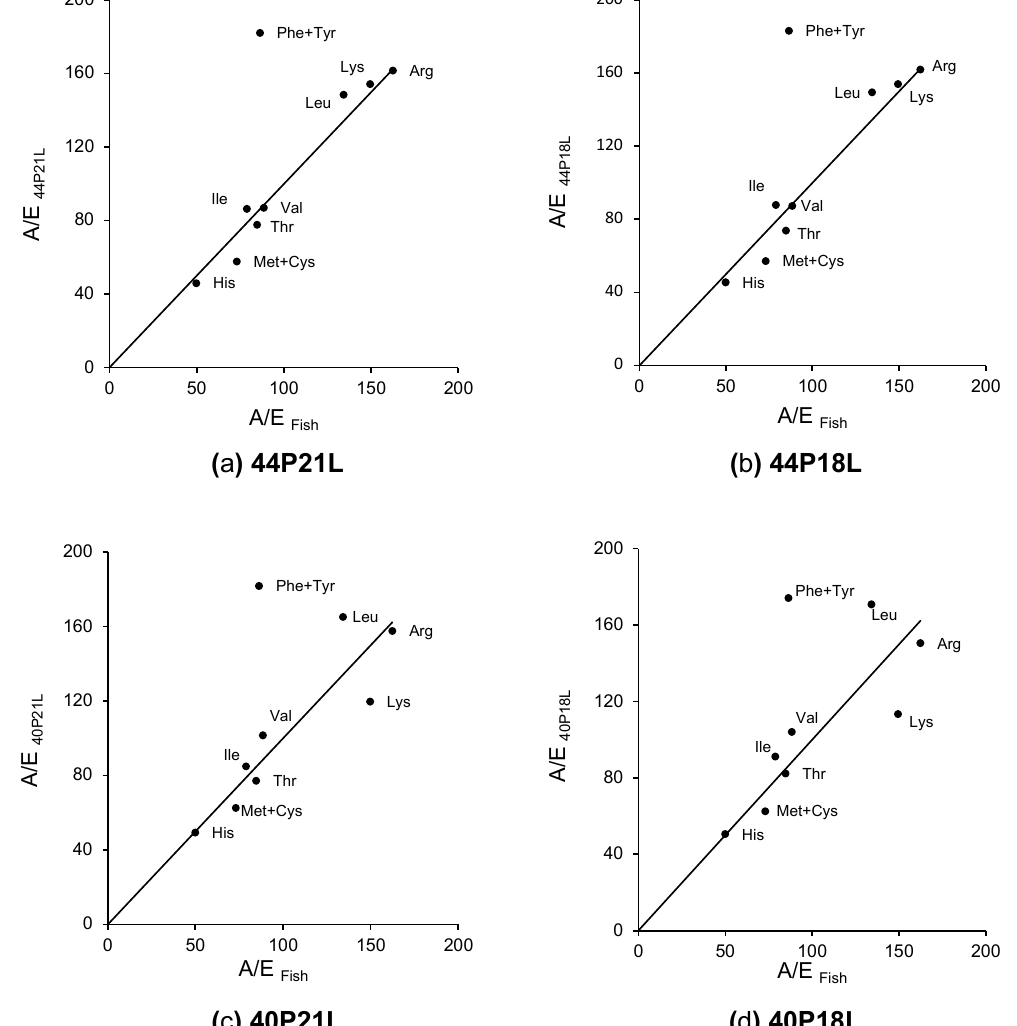
Figure 4. Comparison of the A/E ratios of the experimental diets: ( a ) 44P21L; ( b ) 44P18L; ( c ) 40P21L; ( d ) 40P18L with the A/E ratios of gilthead seabream juveniles.